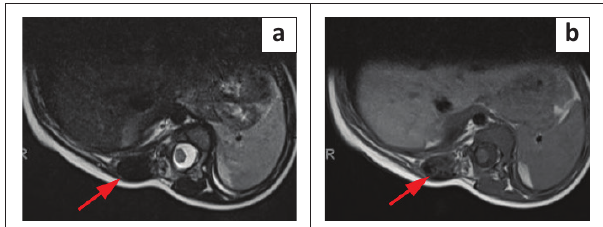
FIGURE 7: T1W and T2W axial images illustrated a right paraspinal muscle lesion (red arrows), T1W markedly hypointense, and T2W iso to hypointense suspected radiologically to be a mass, subsequently confirmed as benign fibro-connective